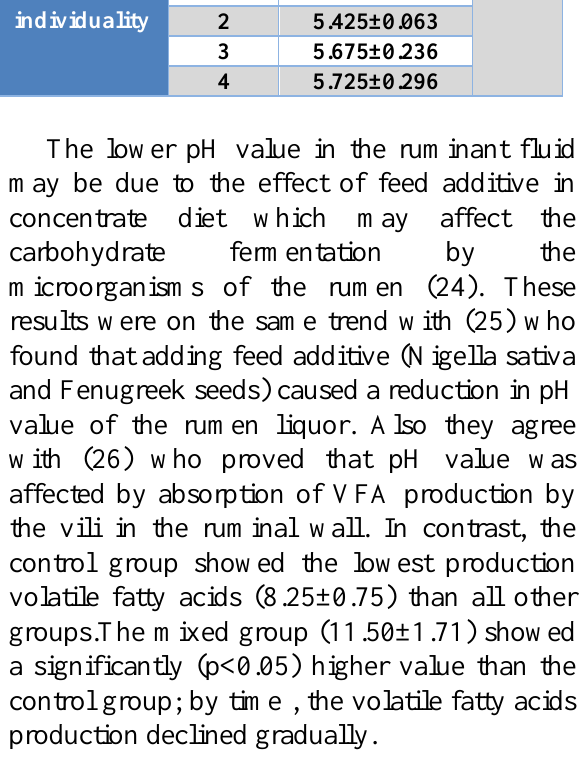
Table, 3: Effect of using Ocimum basilicum and/or Cuminum cyminum on rumen VFA during different periods and Awassi ram individuality.